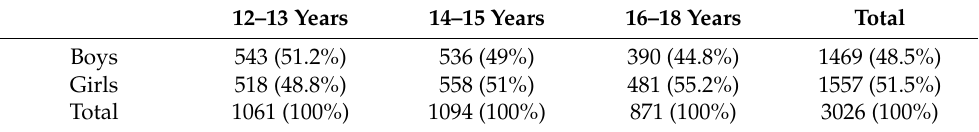
Table 1. Description of the sample: frequency and percentage of boys and girls in the three age